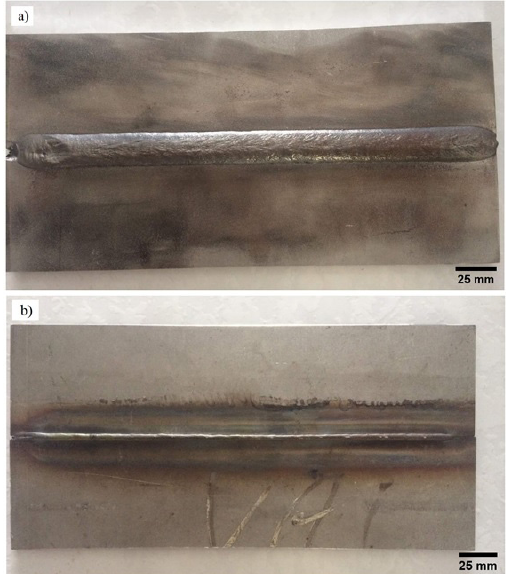
Figure 4. (a) Visual aspect of the chamfer filled. (b) Visual aspect of the weld